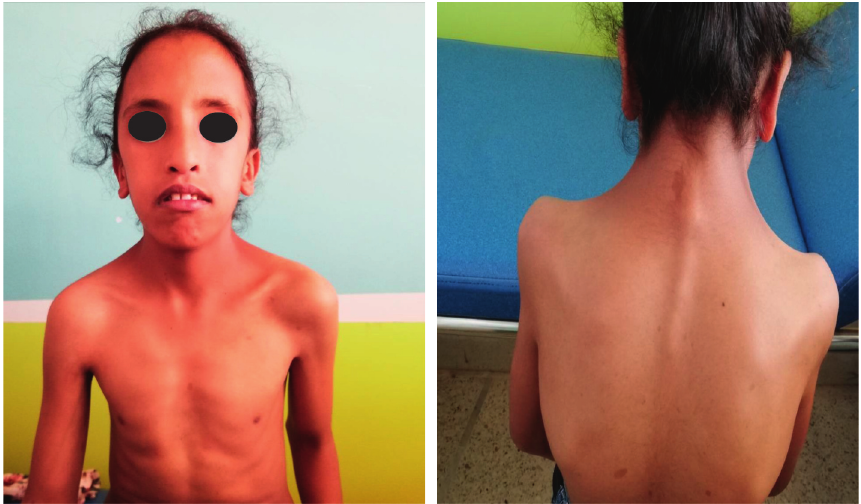
Figure 2: Characteristic appearance with webbed neck, shielded chest, and a low posterior hair